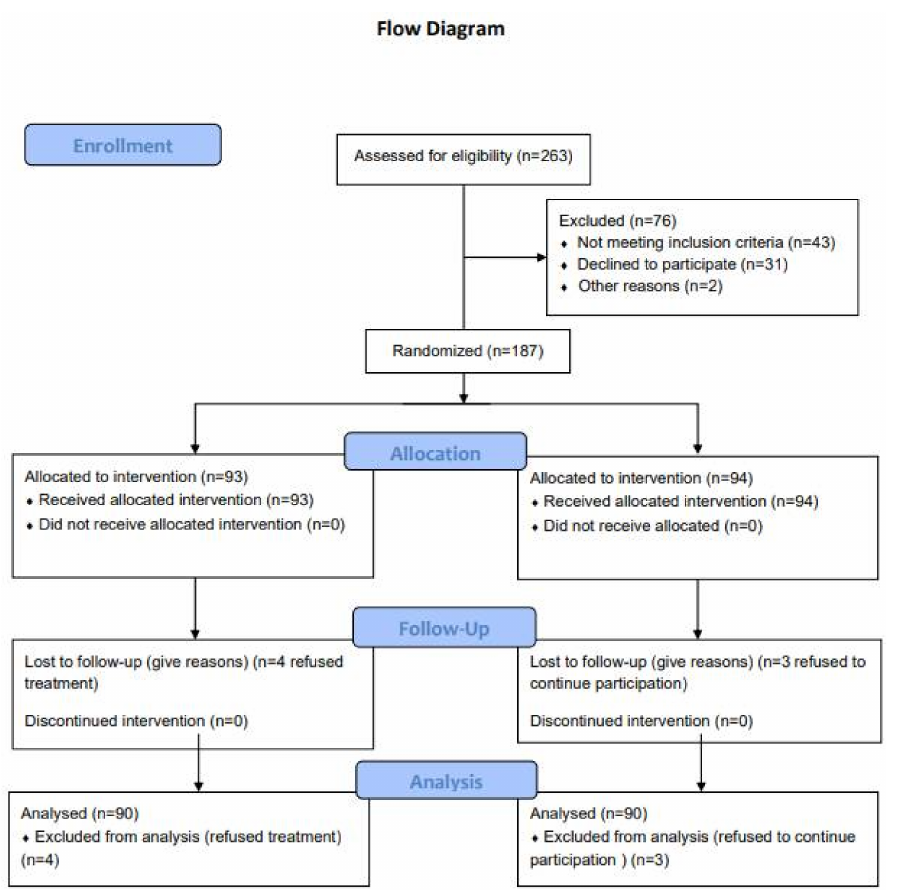
Figure 1. CONSORT flow chart. This figure shows the flow of patients through the trial according to the criteria recommended in the CONSORT